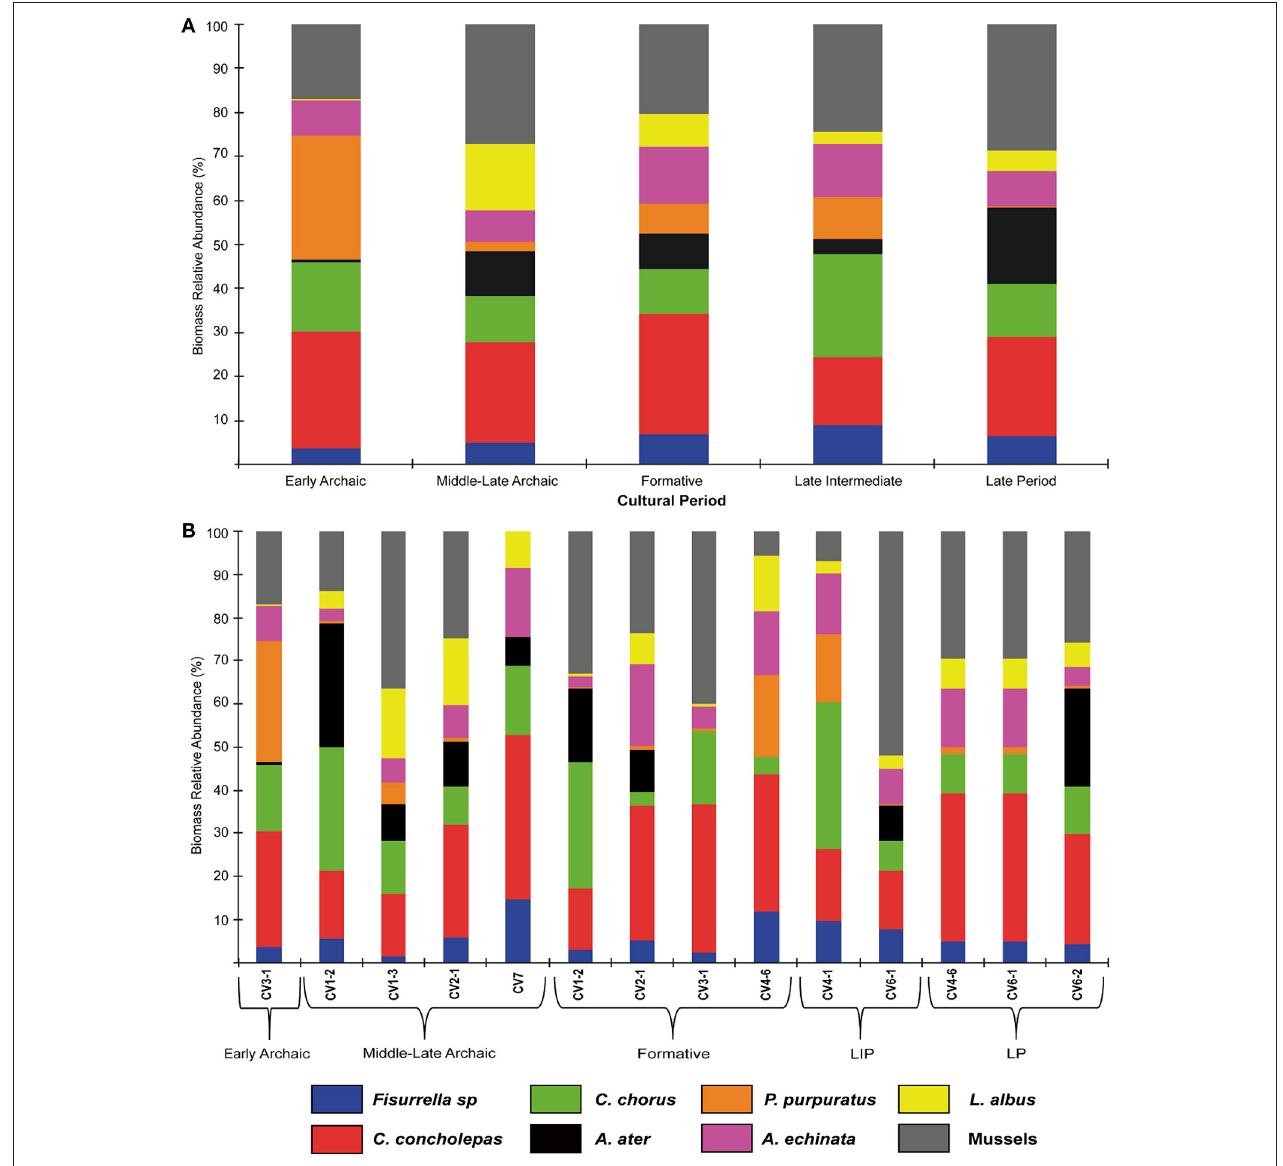
FIGURE 3 | (A) Percent biomass relative abundance for each of the major archeological periods described for the Caleta Vitor archeological sites. Different colors pertain to different taxa after the legend at the bottom. (B) Same as (A) , but for each of the different archaeological sites at Caleta Vitor.